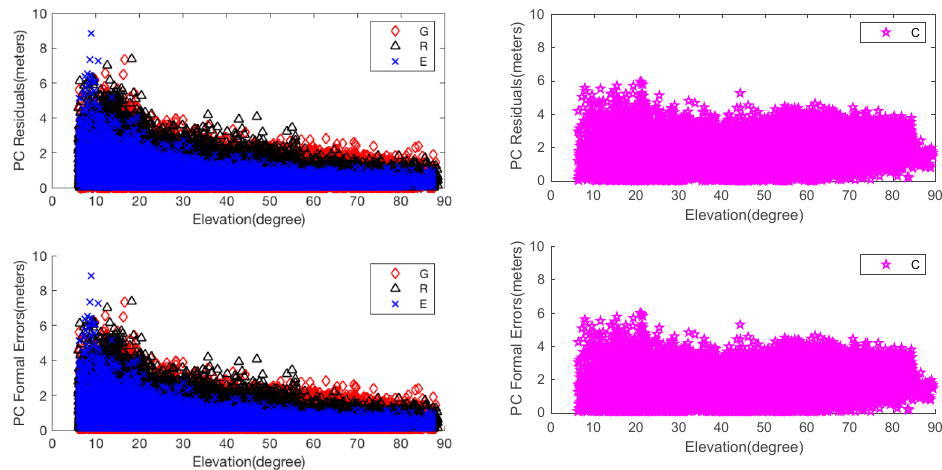
Figure 3. EM-PPP absolute pseudo-range combination (PC) residuals and formal errors of JFNG station at 50th iteration: Left two pictures are the PC residuals and their formal errors (square root of observation matrix R t ) of GPS, Glonass and Galileo, respectively. Similarly, the right two pictures show the PC residuals and formal errors of BeiDou.